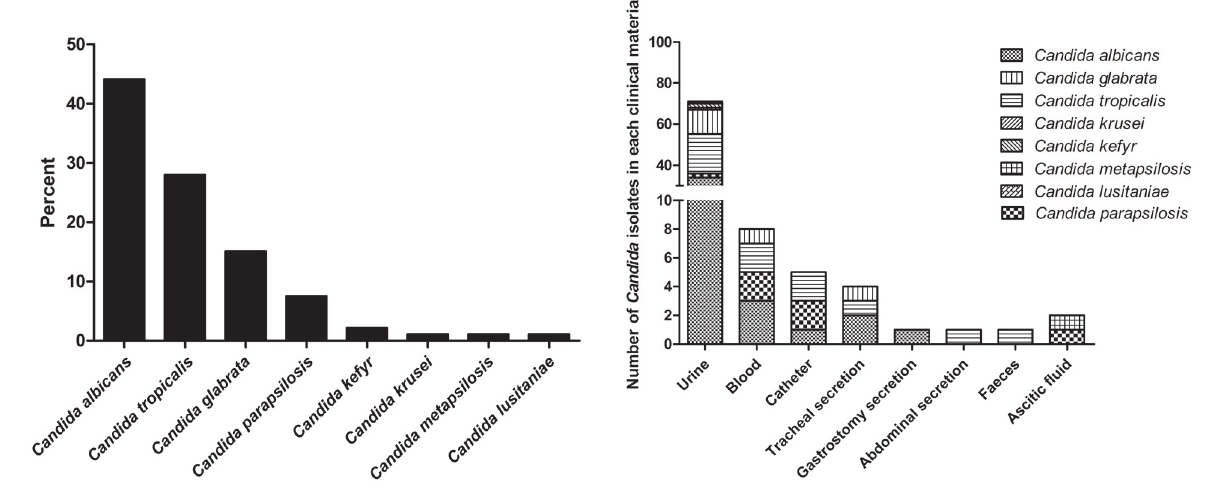
Figure 2 - Number of species Candida isolated from each clinical source. The majority of clinical isolates were C. albicans in urine samples.